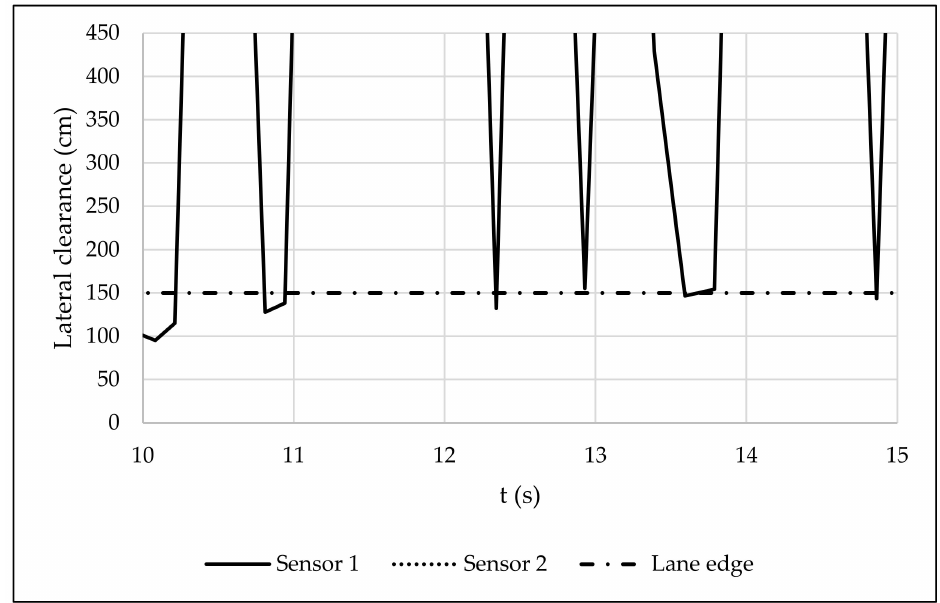
Figure 11. Lateral clearance during data collection.